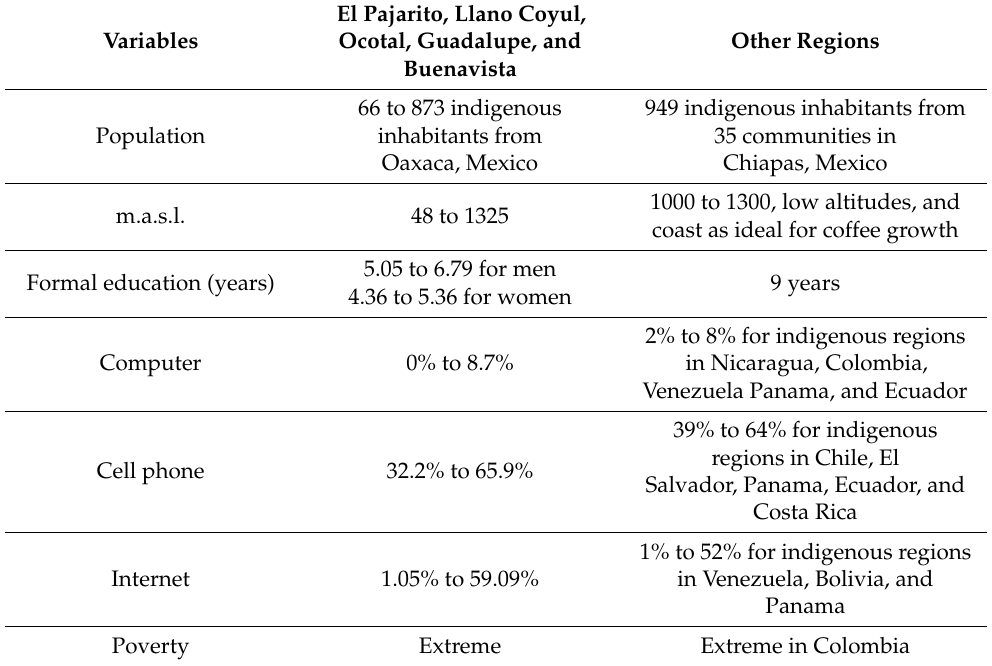
Table 7. Discussion of variables of the